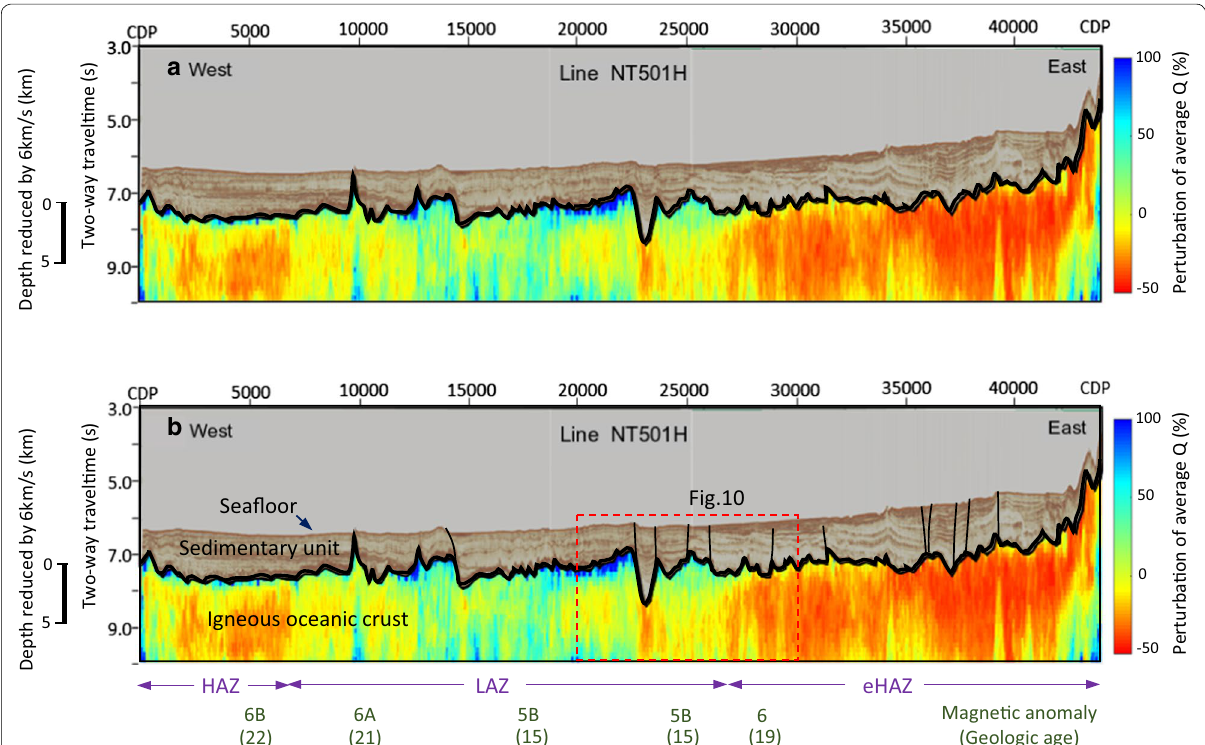
Fig. 9 Composite profile of conventional seismic reflection and attenuation profiles without fault interpretation ( a ) and with fault interpretation ( b ). A rough scale of magnetic anomalies and corresponding geologic ages from Kido and Fujiwara (2004) is provided at the bottom horizontal axis of the figure ( b ). Here we refer Ogg (2012) as geomagnetic polarity time scale. A rectangle with red broken line marks the area expanded in Fig.